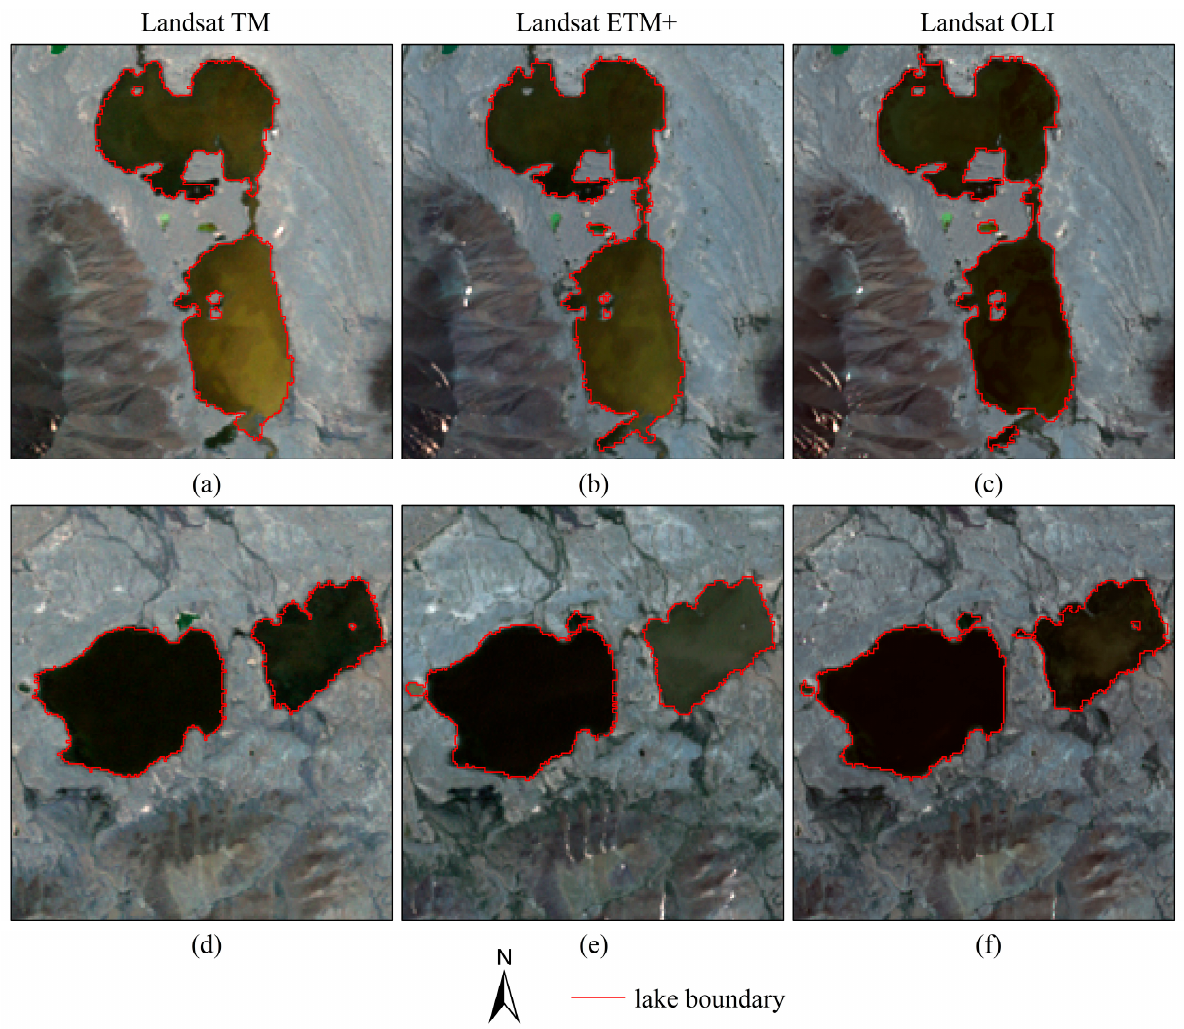
Figure 16. Results of the proposed method in study area 4: ( a , d ) are the results in the image of Landsat TM; ( b , e ) are the results in the image of Landsat ETM+; ( c , f ) are the results in the image of Landsat OLI.